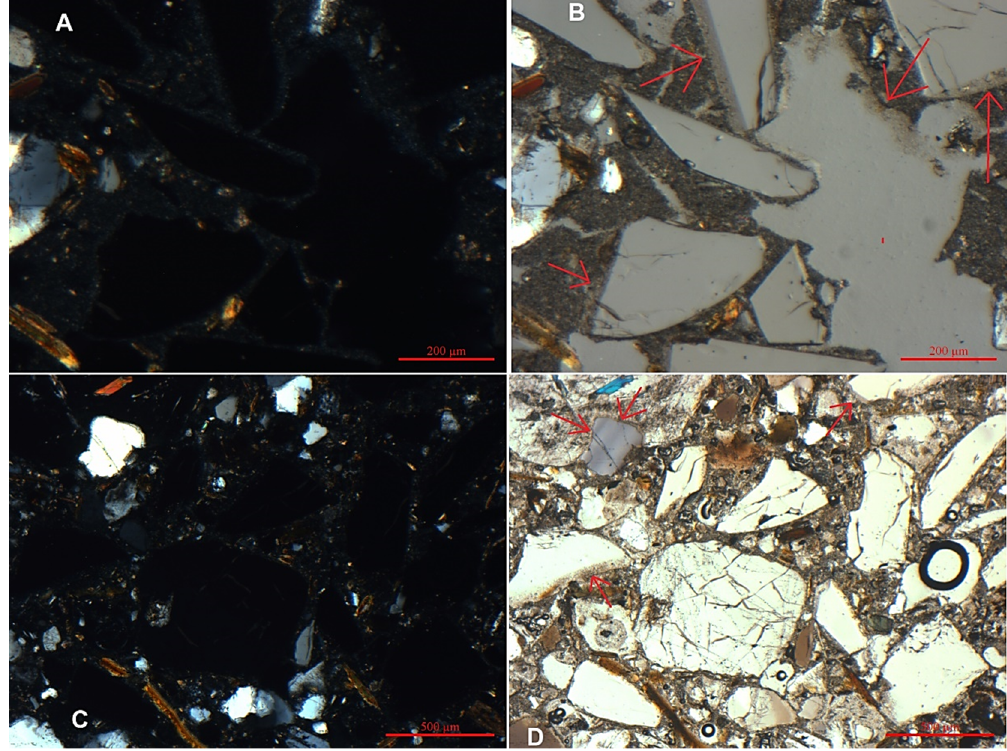
Figure 9. Microscopic images in observations with a crossed-polarized lens, ( A , C ), and parallel polarized lens, ( B , D ).